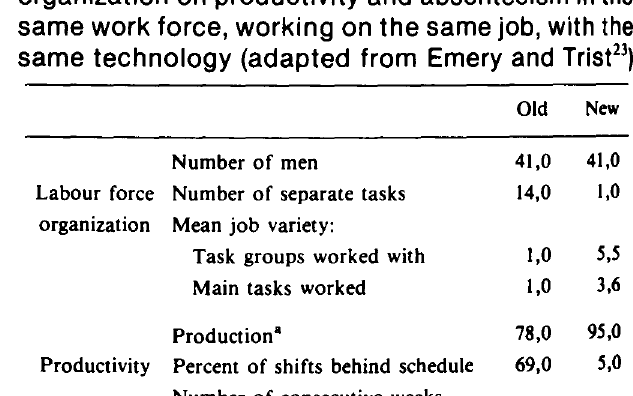
The effects of a change in labour force organization on productivity and absenteeism in